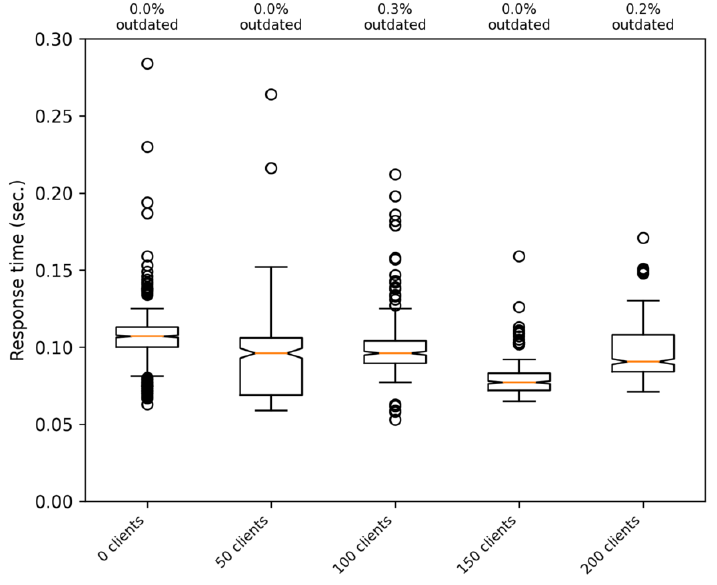
Figure 11. Effect on the response time of a real client of a variable number of concurrent syn- thetic